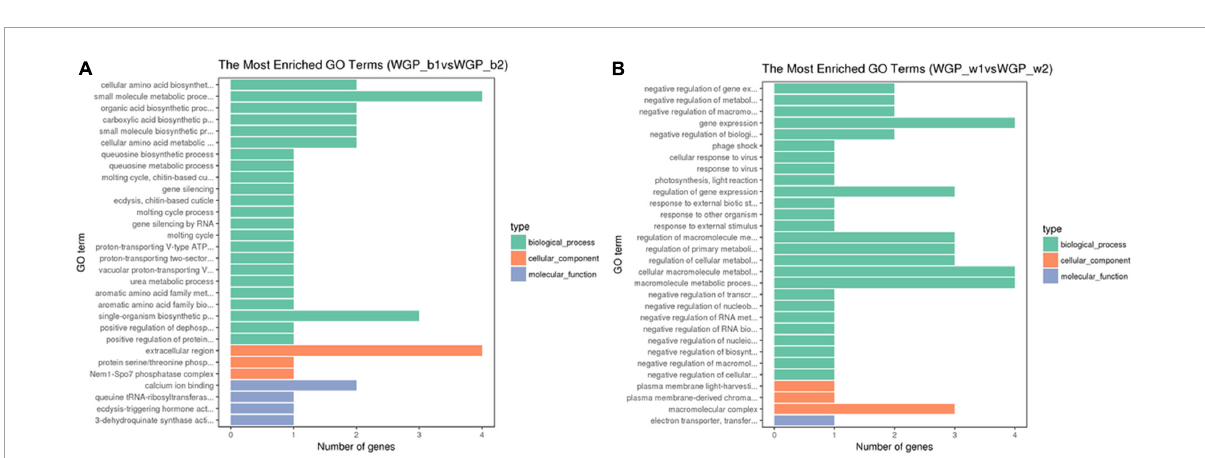
FIGURE3 Gene ontology (GO) terms of DEGs enrichment graph. The ordinate is the enriched GO terms, and the abscissa is the number of differential genes in this term. Green is represent biological processes, orange is represent cellular components, and blue is represent molecular